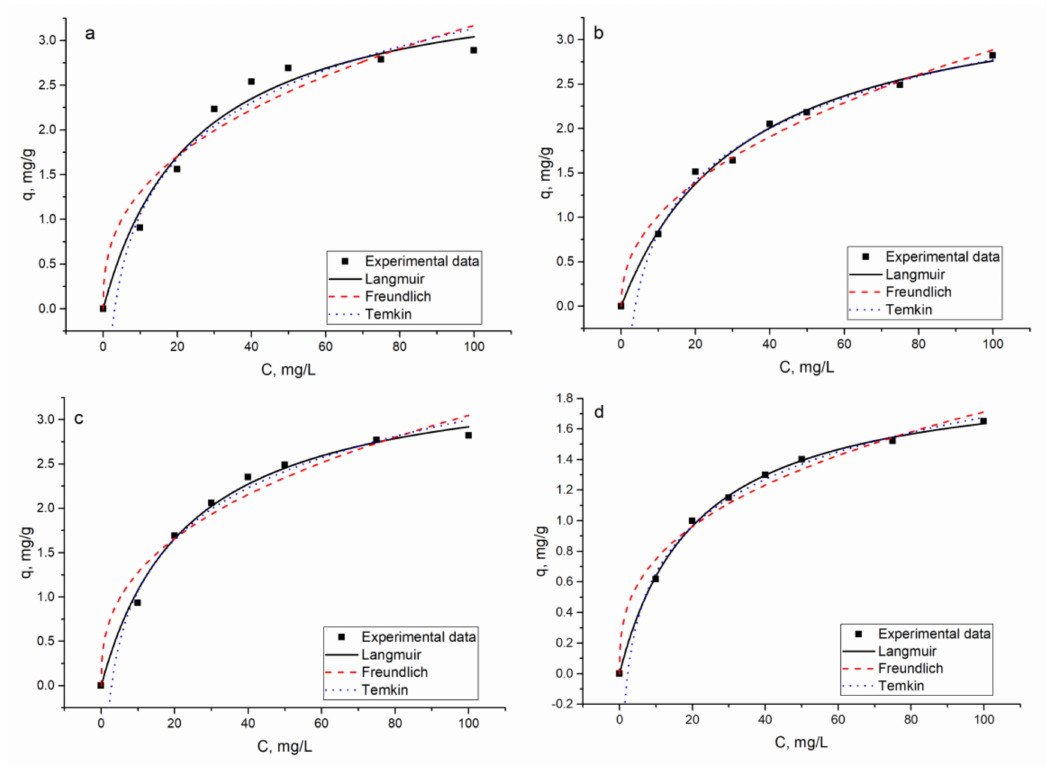
Figure 8. The adsorption isotherms for Ni(II) ion removal on hybrid adsorbent: ( a ) Ni(II), ( b ) Ni(II)-